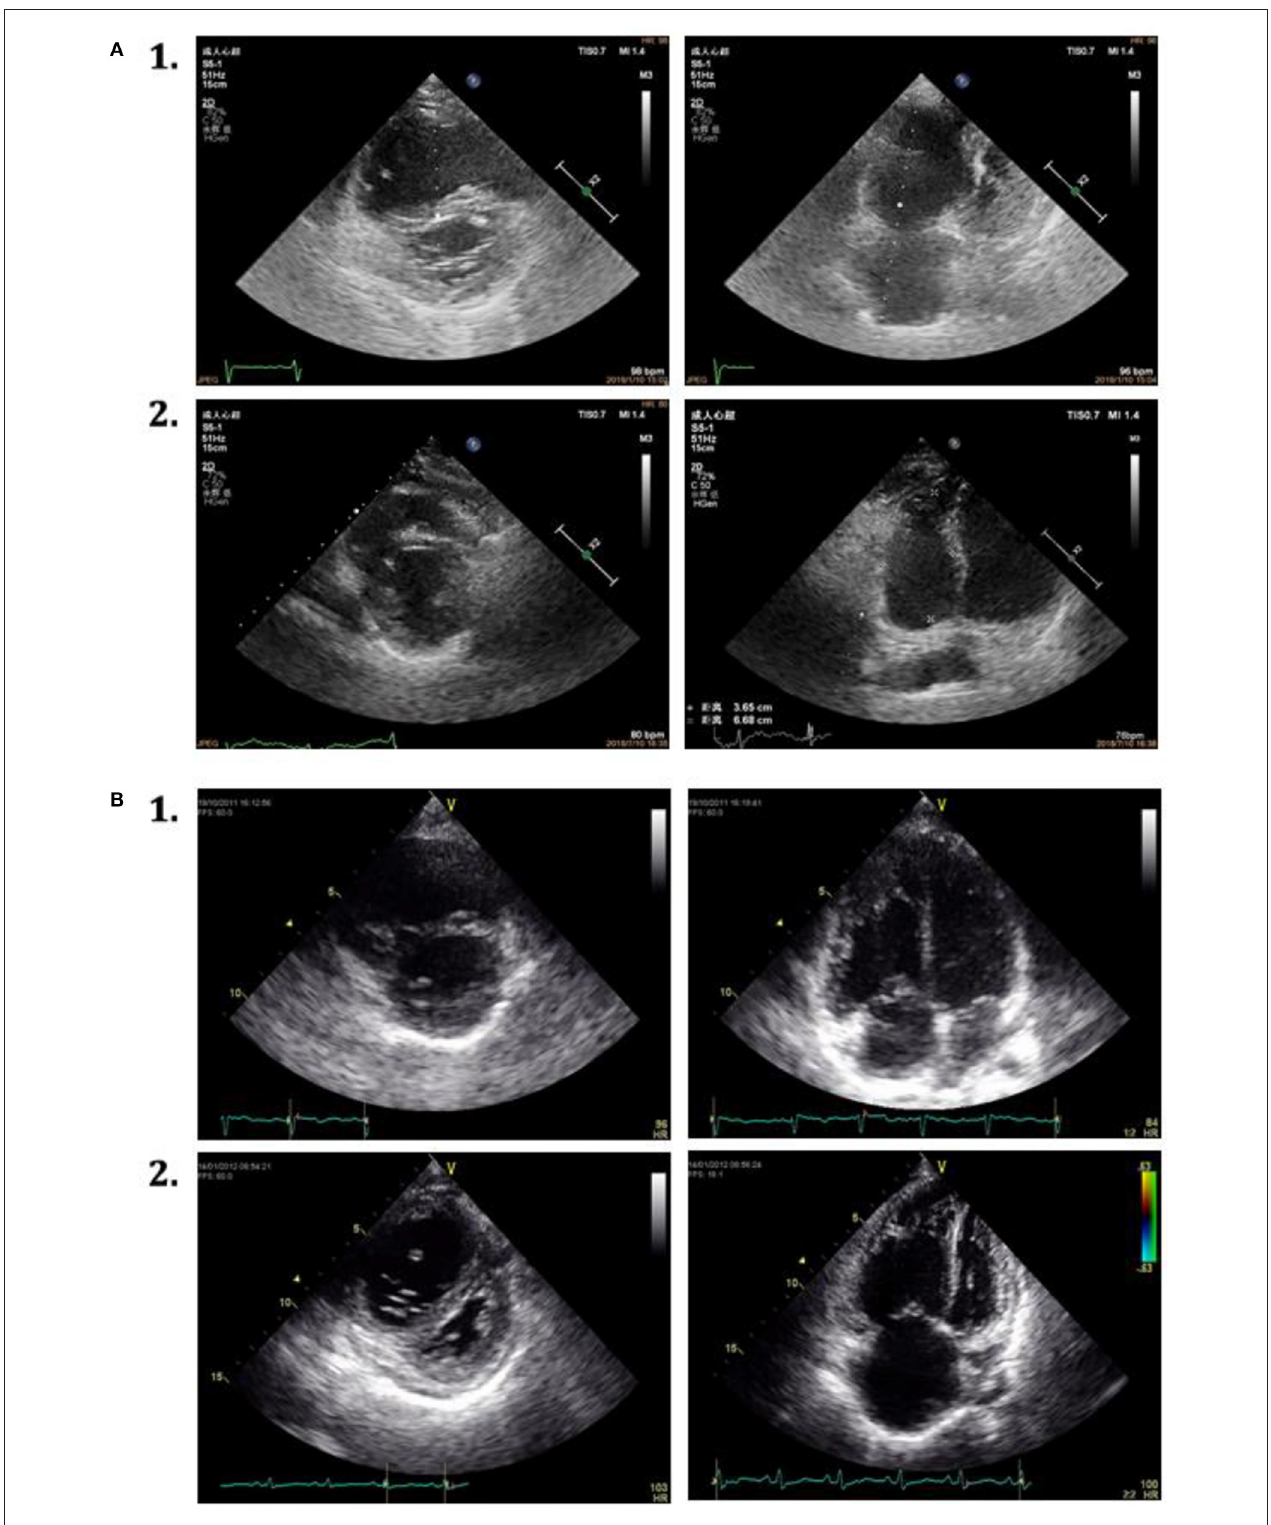
FIGURE 3 | Echocardiographic parasternal short-axis view and apical four-chamber view in 2 patients with IPAH. (A) 1. The characteristics at baseline. 2. Attenuated right heart remodeling of the same patient at the first follow-up assessment. (B) 1. The characters at baseline. 2. Without attenuated right heart remodeling of the same patient at the first follow-up